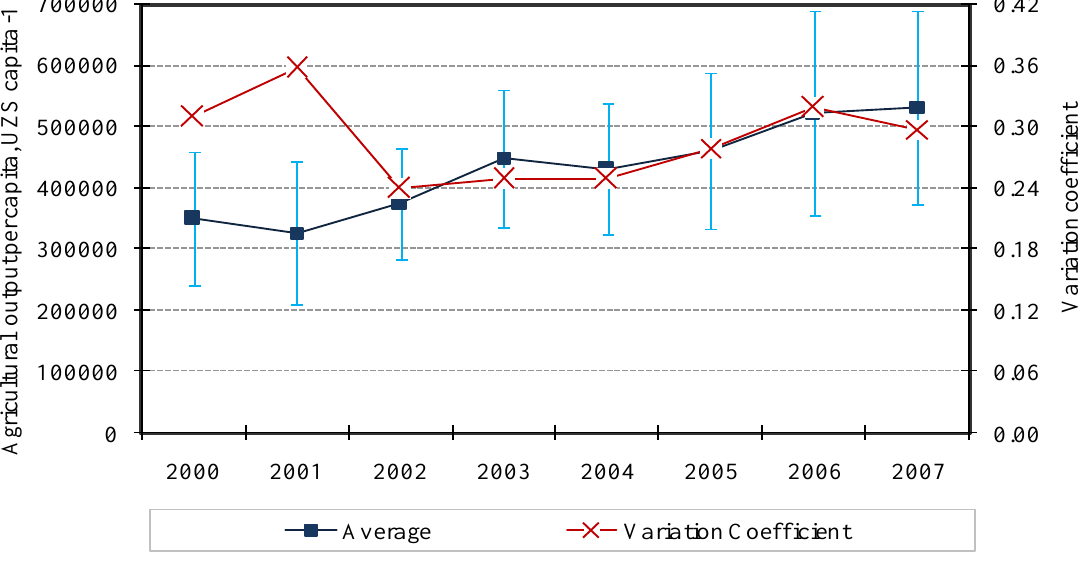
Figure 12. Temporal per capita agricultural revenue and its differentiation, 2000−2007.